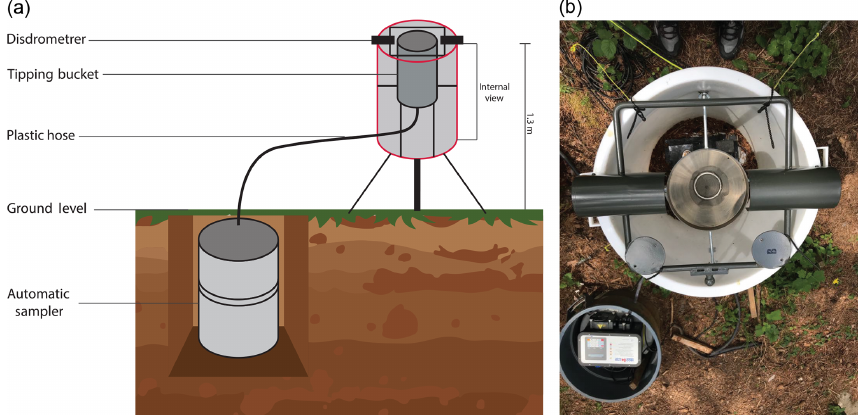
Figure 2. Set-up for continuous measurement and sampling of open rainfall and throughfall. Diagram of the experimental equipment (a) and top view of the equipment installed in the forest stand (b)